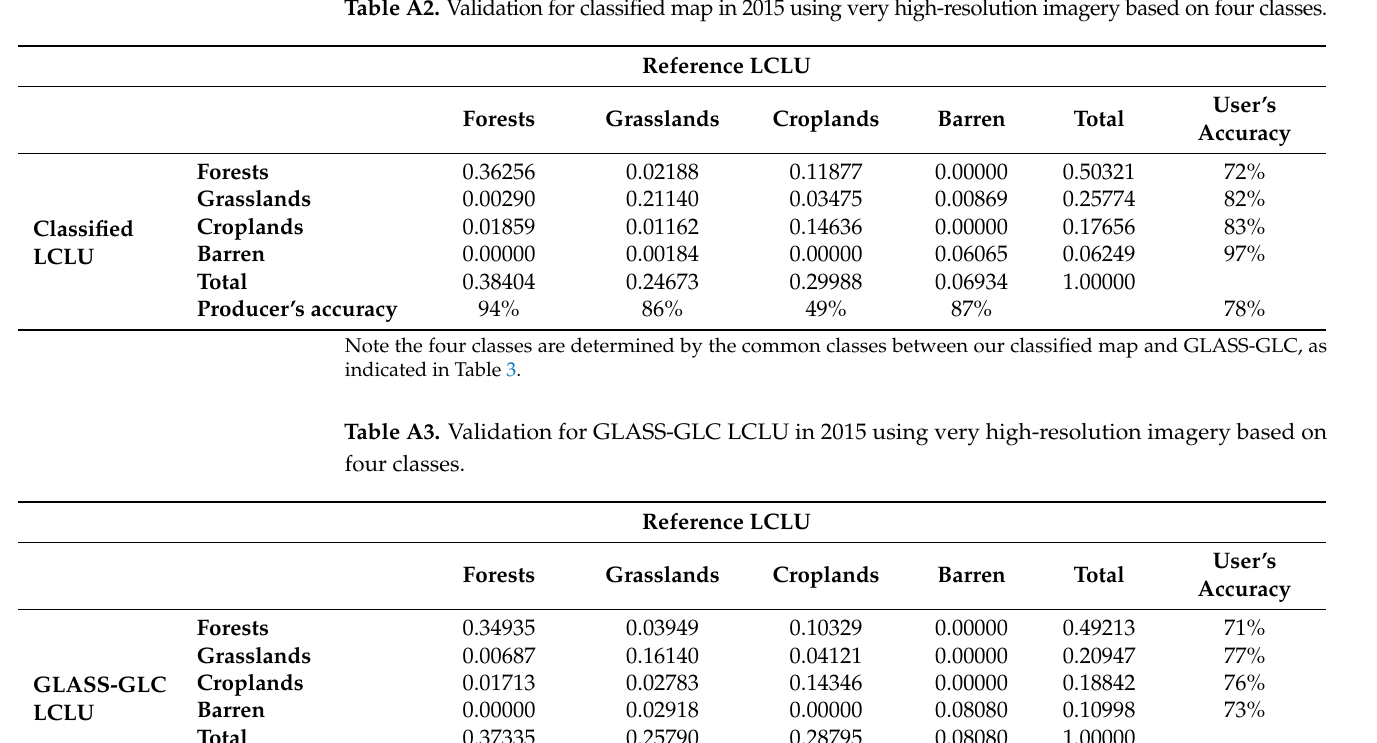
Table A2. Validation for classified map in 2015 using very high-resolution imagery based on four classes.